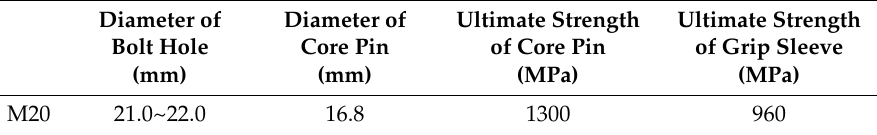
Table 3. Material properties of blind bolts.